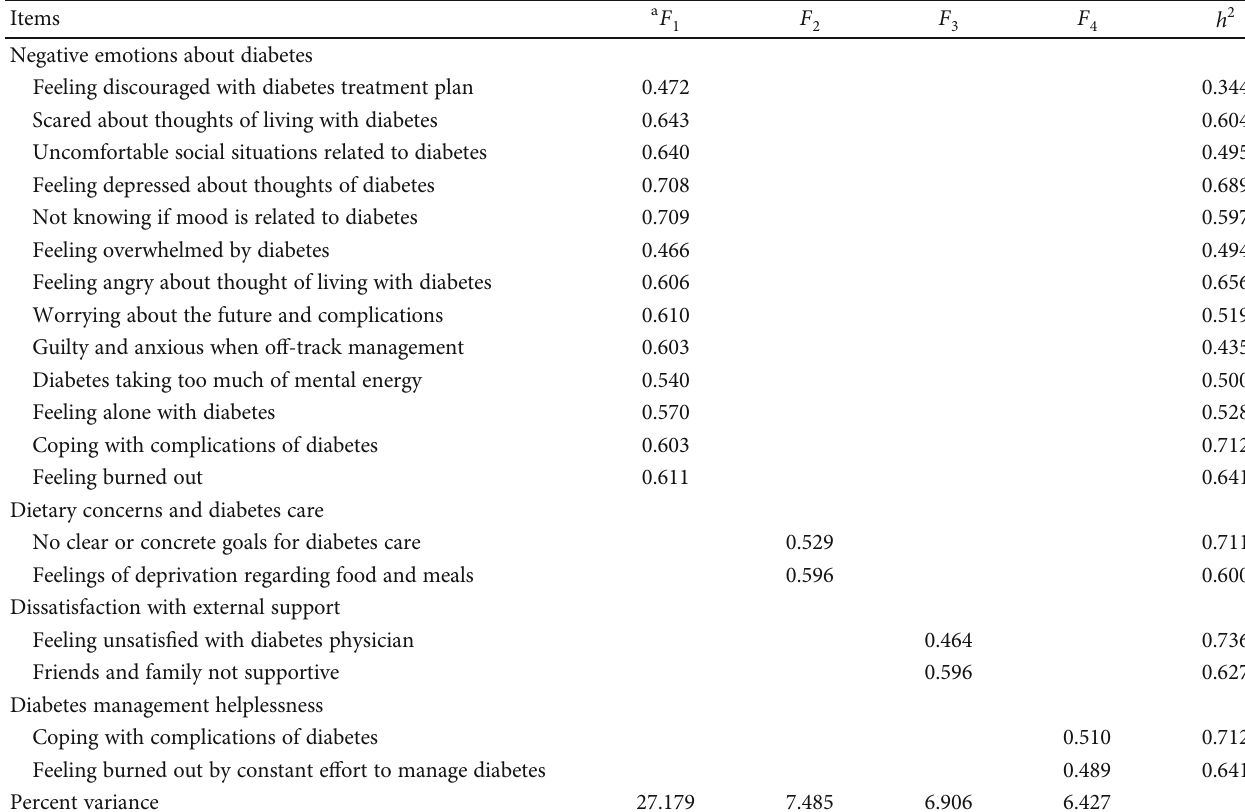
Table 5: Factor loadings, communalities ( h 2 ), and percent of variance for principal factor extraction and varimax rotation on items of diabetes